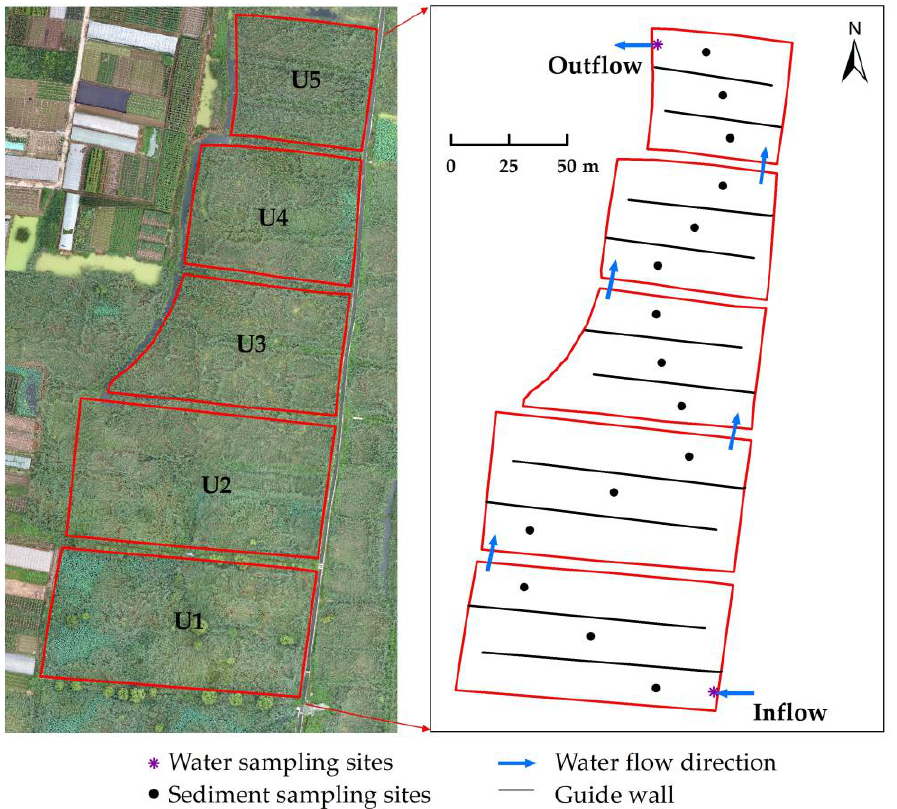
Figure 1. Basic information on the multi-stage surface flow constructed wetland.